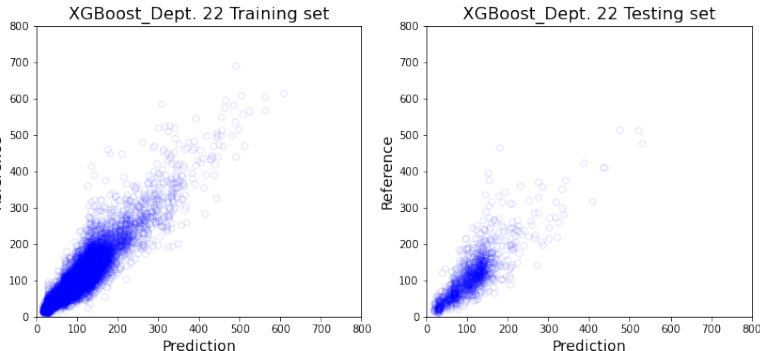
Figure A16. Model Performance of XGBoost on Dept.22. The visualization of training and testing data for department specific model on department 22 with XGBoost.